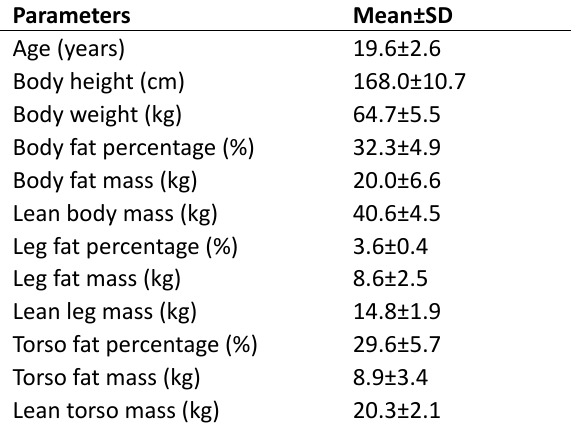
Table 1. The descriptive statistics of physical and total/ segmental body composition parameters (n=16). Data are reported as mean±SD.